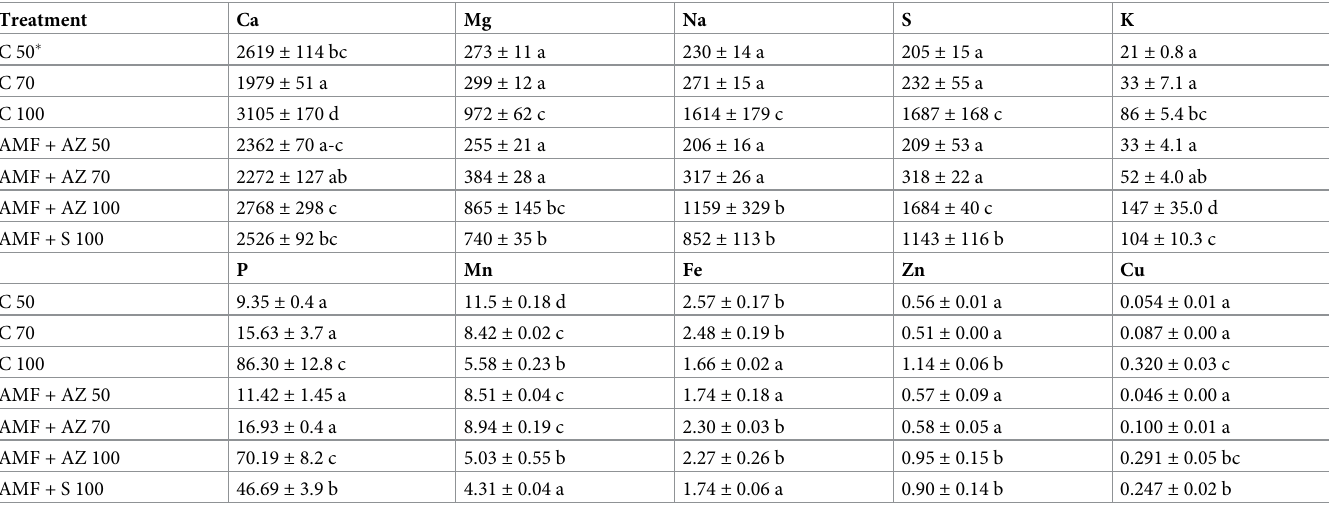
Table 3. Effects of soil microorganisms on soluble minerals (mg kg -1 DW) in substrate after tomato transplants cultivation.